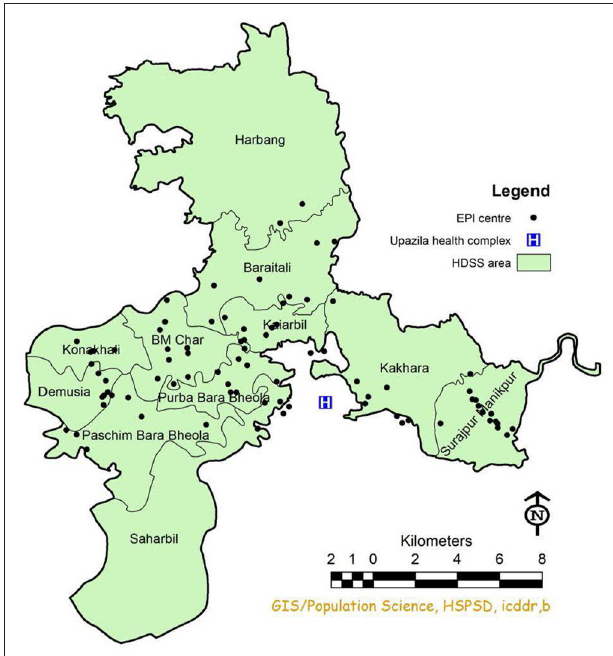
FIGURE 1 | Map showing EPI centers in Chakaria HDSS area.